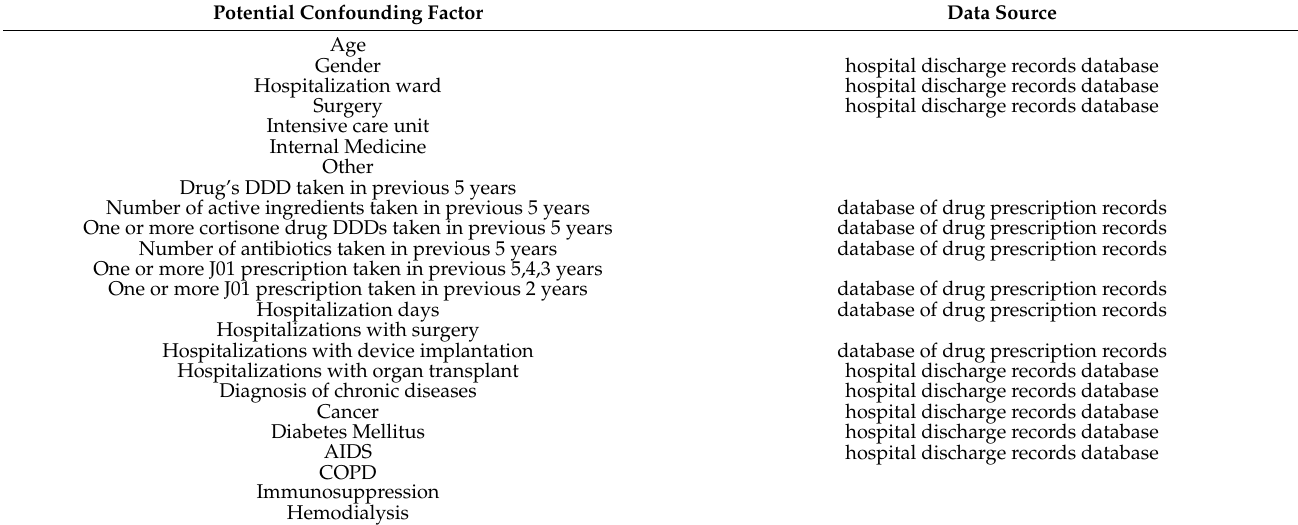
Table 4. Potential risk factors for 3GC-resistance in E. coli and their data